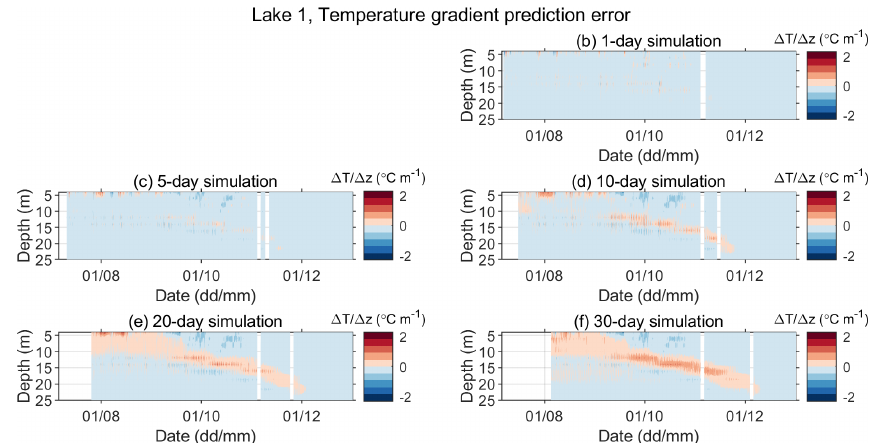
Figure A5. Error in the predicted vertical gradient of water temperature ( P i − O i ) in Lake 1 for different simulation lengths in the period between 6 July and 31 December 2019. Panel (a) is omitted so that the panels’ positions for different simulation lengths correspond to those in Fig. 3.